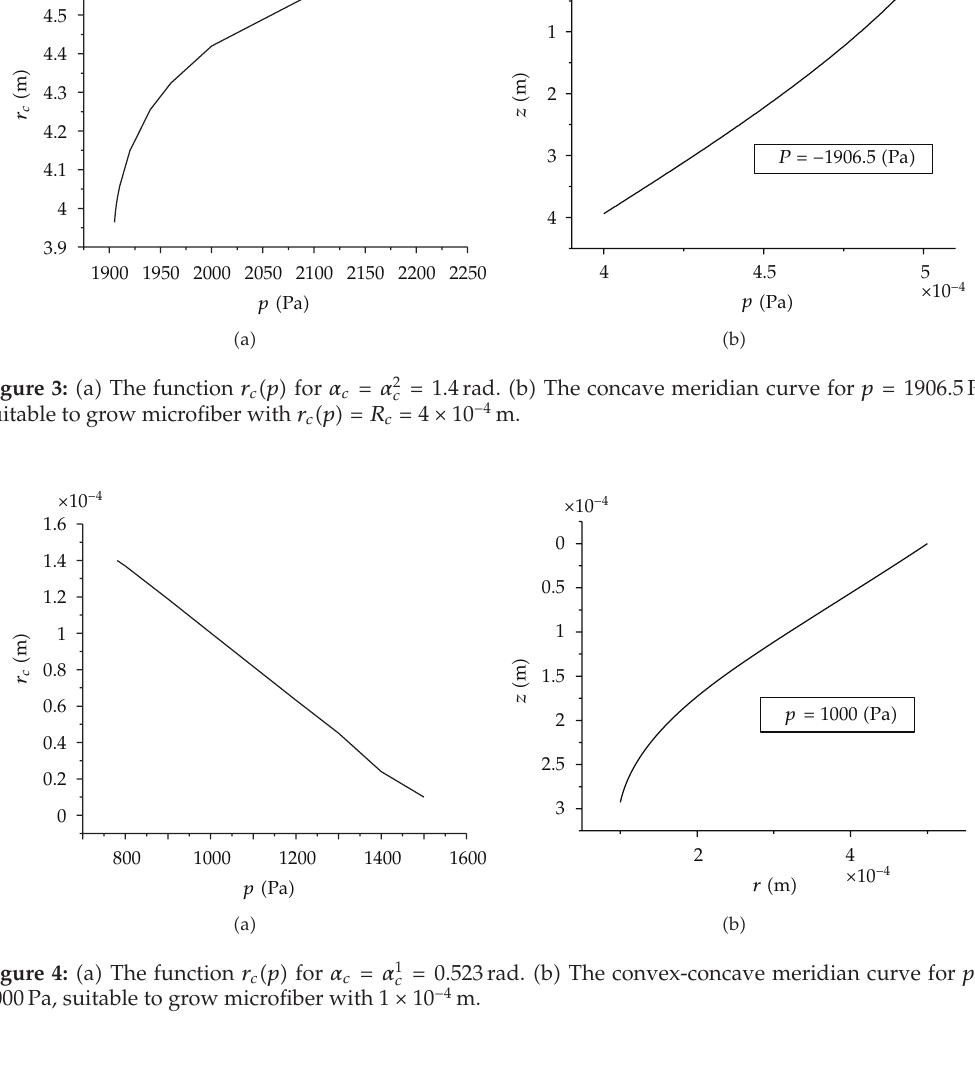
Figure 4: (cid:6) a (cid:7) The function r c (cid:6) p (cid:7) for α c (cid:8) α 1 1000Pa, suitable to grow microfiber with 1 × 10 − 4